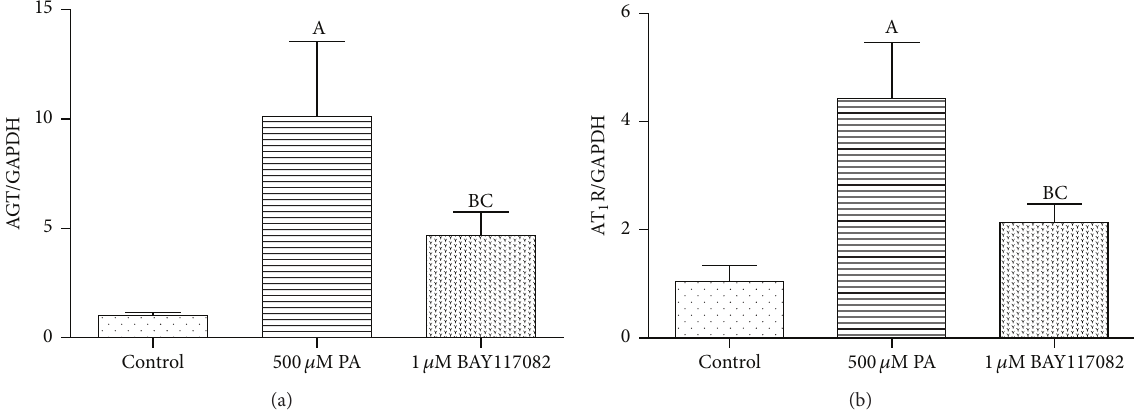
Figure 5: BAY117082 pretreatment partly prevented upregulation of AGT and AT 1 R mRNA expressions. Data are presented as mean ± SD. (A) 𝑃 < 0.05 versus control, (B) 𝑃 < 0.05 versus PA group, and (C) 𝑃 > 0.05 versus control ( 𝑥 ± 𝑠 , 𝑛 = 9 ).